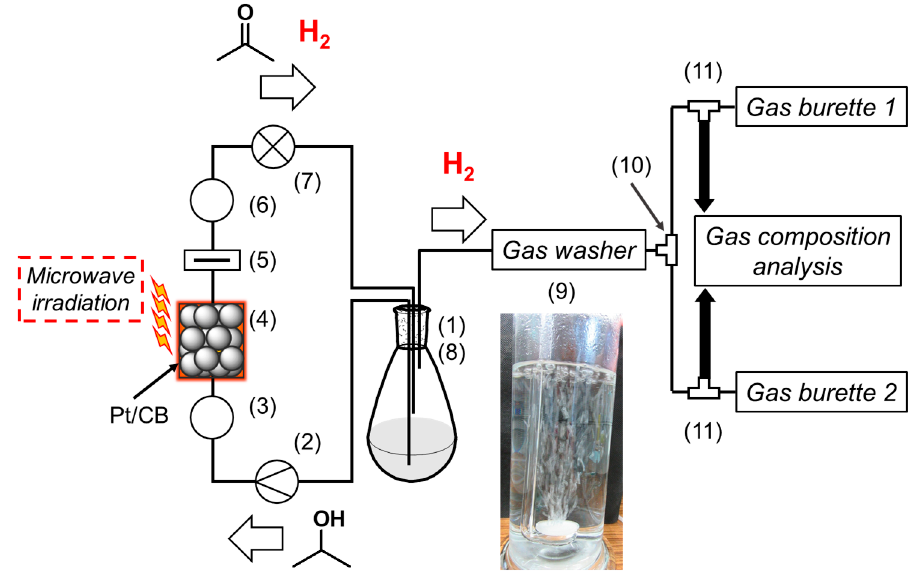
Figure 3. Conceptual reaction system. (1) Reservoir. (2) Pump. (3) Pressure gauge at an entrance. (4) 5% Pt / CB-packed catalyst cartridge. (5) Inline filter. (6) Pressure gauge at an exit. (7) Backpressure regulator. (8) Receiver. (9) Water-filled gas washing bottle. (10 and 11) Three-way stopcock.